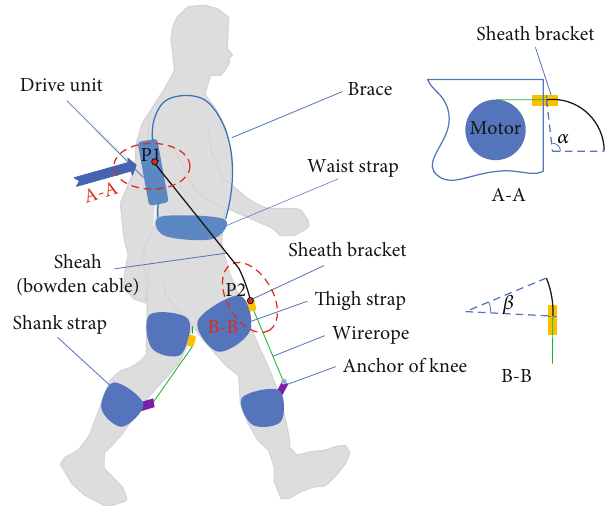
Figure 1: Sketch of a fl exible exoskeleton for the knee